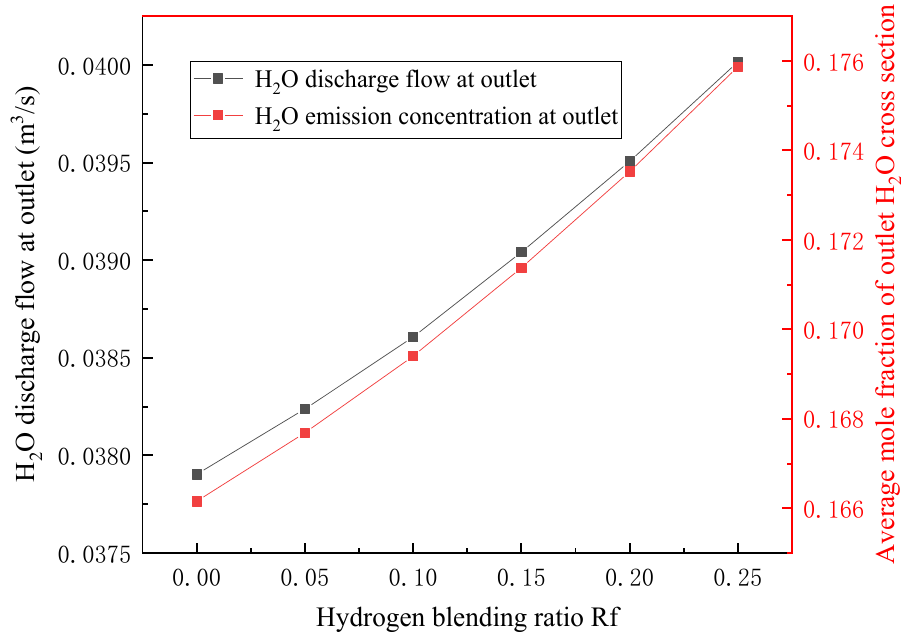
Figure 12. Emission concentration and discharge flow of CO 2 at outlet.